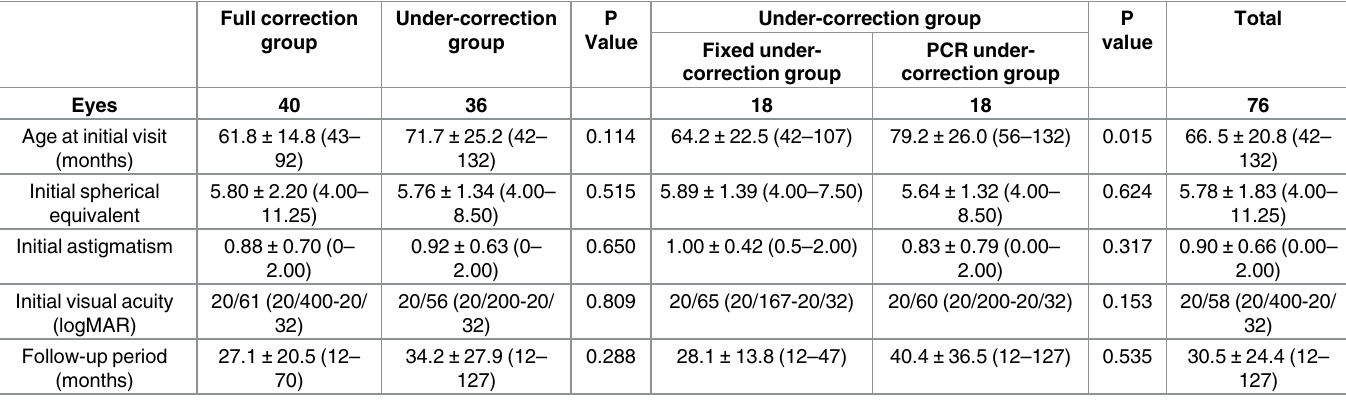
Table 1. The demographic characteristics of the